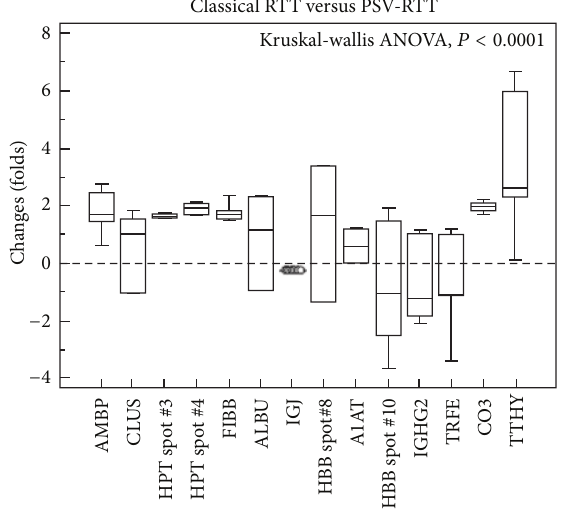
Figure 2: Plasma proteins expression in sisters with classical Rett syndrome as protein expression ratios of classical RTT versus PSV- RTT plasma proteome. Data are expressed as box-and-whiskers plots. Results of the Kruskal-Wallis ANOVA are